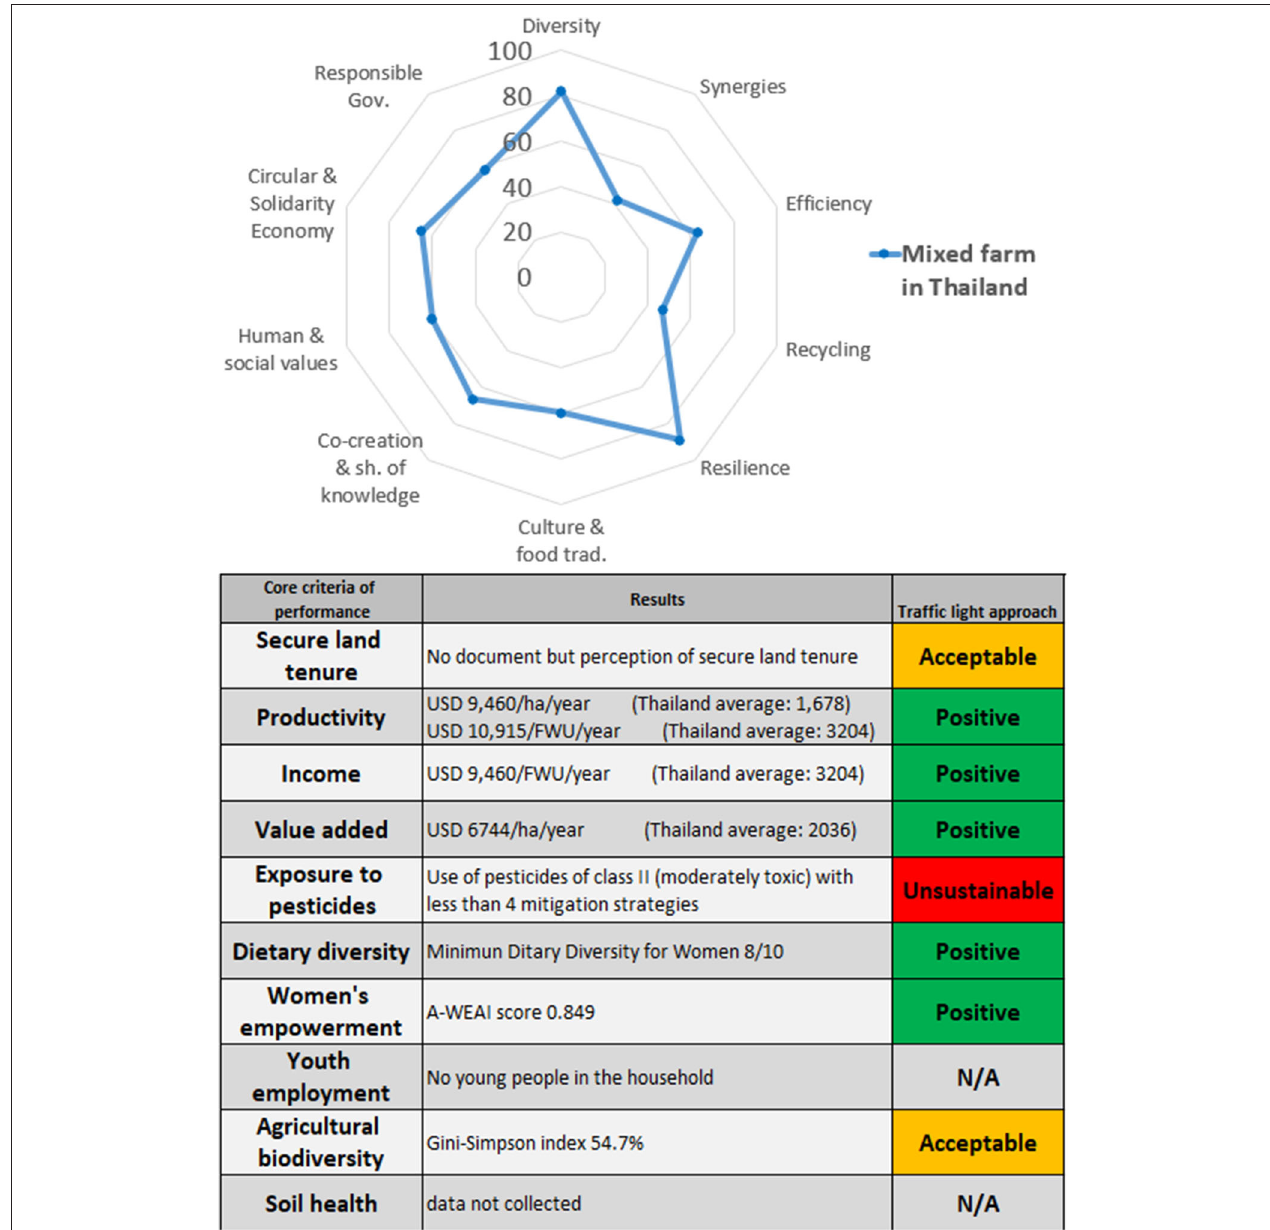
FIGURE 4 | Results of Step 1 and Step 2 applied to a farm in